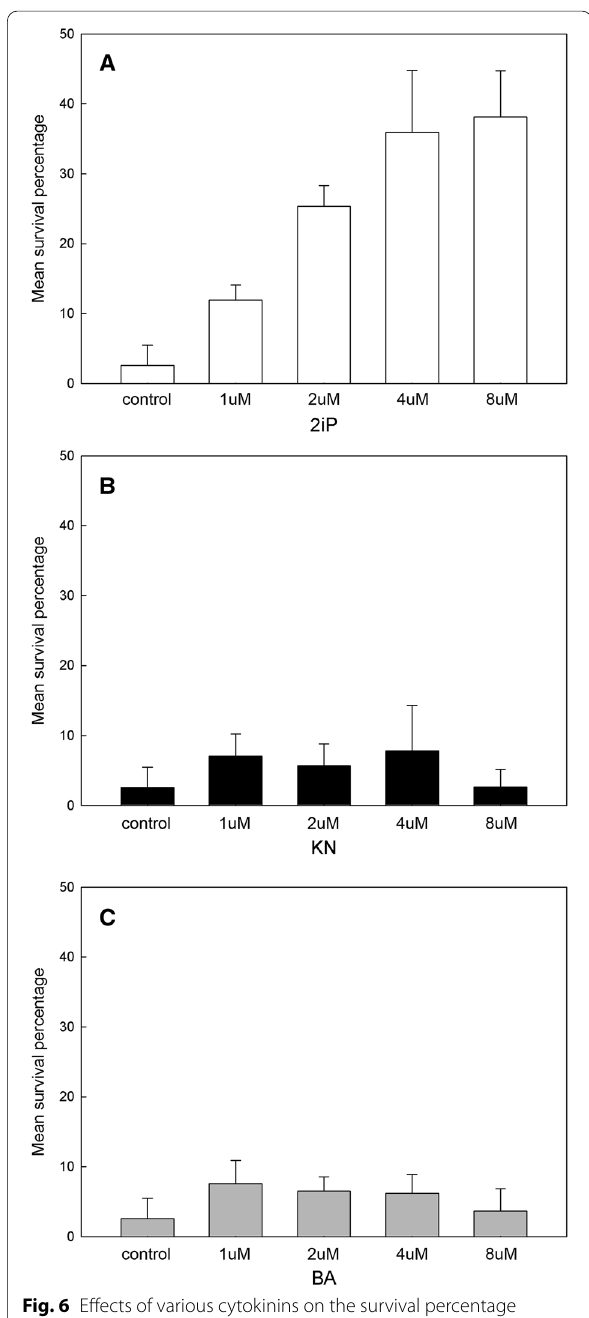
Fig. 6 Effects of various cytokinins on the survival percentage of C. subtropicum protocorms after 6 months of culture. A 6‑(γ,γ‑Dimethylallylamino)purine (2iP). B Kinetin (KN). C 6‑Benzylaminopurine (BA). Error bars represent SE (n